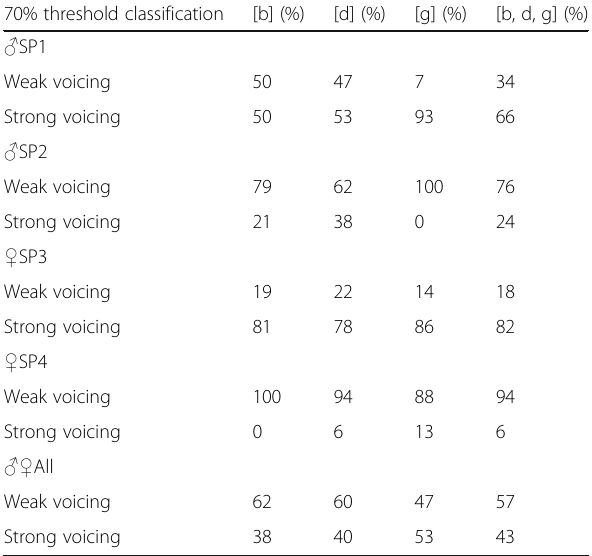
Table 13 Stops classified (based on oral airflow) as having weak and strong voicing, applying the 70% threshold. Stops